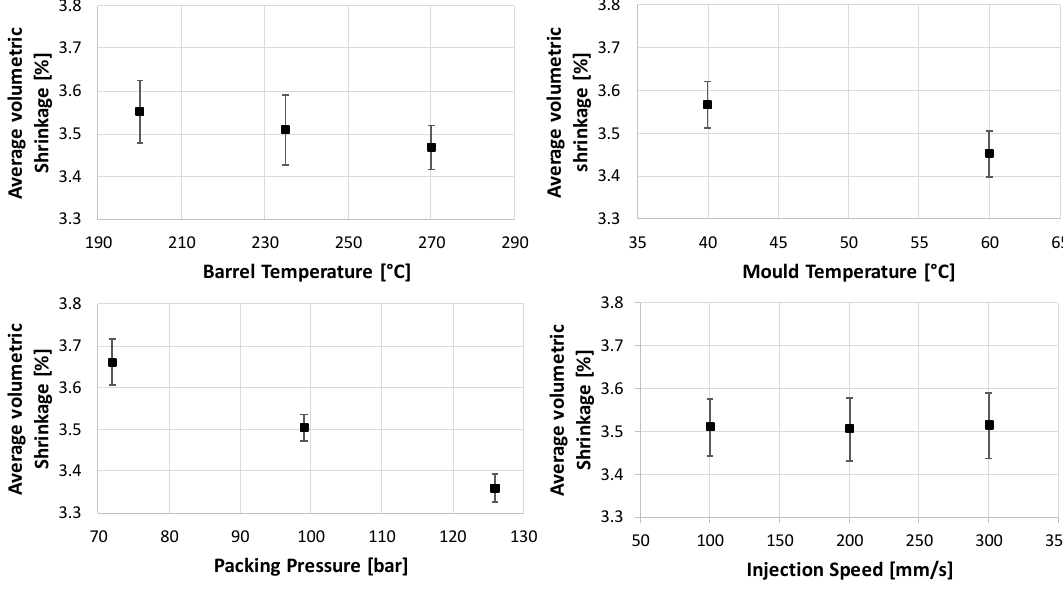
Figure 9. Main effects of chosen parameters on Average Volumetric Shrinkage (AVS): main effects of barrel temperature—T b on AVS ( top left ); main effects of mould temperature—T m on AVS ( top right ); main effects of packing pressure—P p on AVS ( bottom left ); and main effects of injection speed—V i on AVS ( bottom right ).